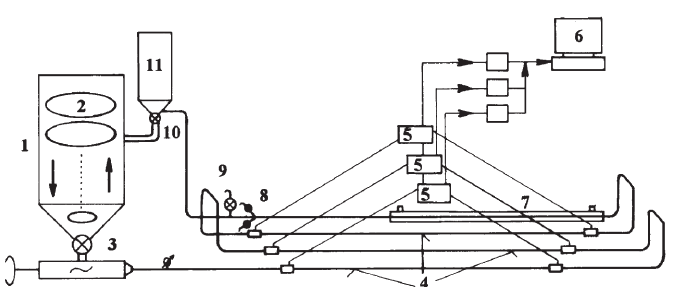
Fig. 1. Tube viscometer with three measuring